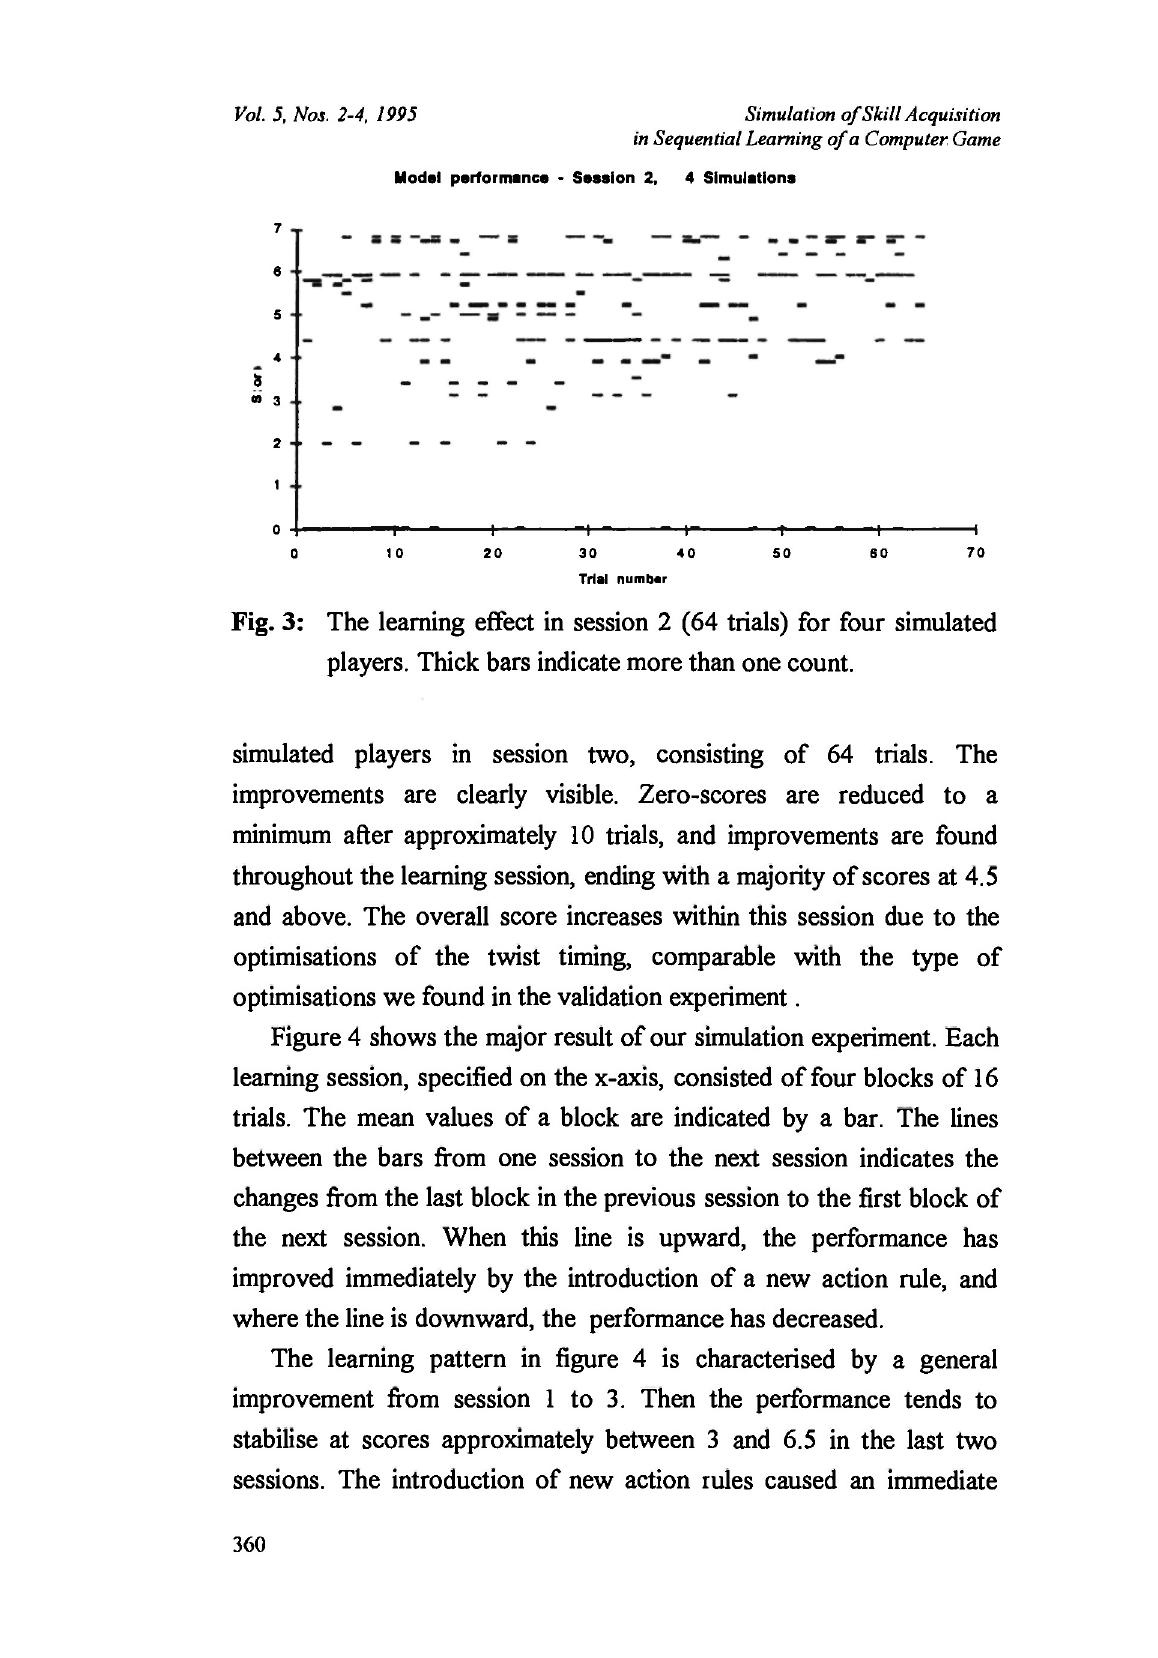
Fig. 3: The learning effect in session 2 (64 trials) for four simulated players. Thick bars indicate more than one